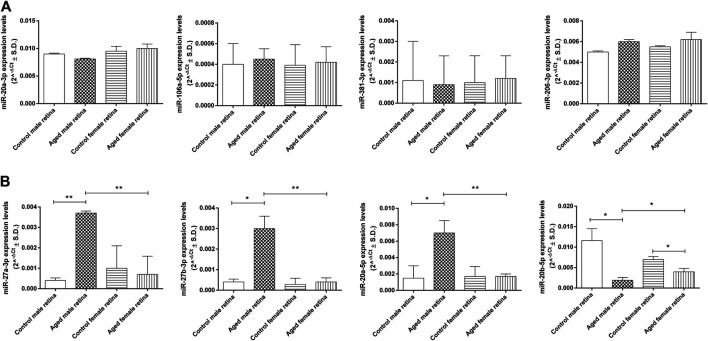
Age-related miRNA expression levels in aged retina. (A) Not dysregulated and (B) dysregulated retina miRNA expression levels. Data are reported as 2^−ΔCt and shown as mean ± SD of n = 10 observations for each experimental group; each run was performed in triplicate. Statistical significance was assessed by using one-way ANOVA, followed by Tukey’s multiple comparisons test. *p < 0.05 and **p < 0.01.